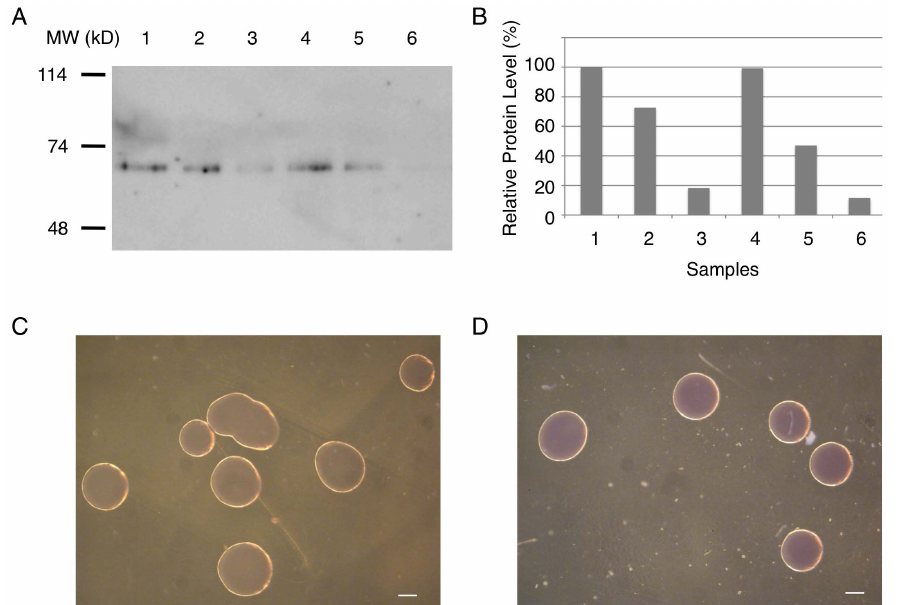
Figure 2. Different expression levels of Lactobacillus-based expression vectors. A) Different levels of mRFP1 expression in Lactobacillus casei were detected by Western blot. A total of 0.9 m g of the whole lysate was loaded into each lane. Lane 1, pLEM415-ldhL-mRFP1; lane 2, pLEM415- emr-mRFP1; lane 3, pLEM415-P59-mRFP1; lane 4, pUCYIT-ldhL-mRFP1; lane 5, pUCYIT-emr-mRFP1; lane 6, pUCYIT-P59-mRFP1. B) Quantification of band intensities from Western blot in Panel A. The expression level of pLEM415-ldhL-mRFP1 was set to 100%. Sample numbers correspond to lanes shown in Panel A. C) Wild type Lactobacillus casei colonies under visible light. D) Colonies of Lactobacillus casei transformed with pLEM415-ldhL- mRFP1 appeared pink under visible light. Scale bars, 100 m